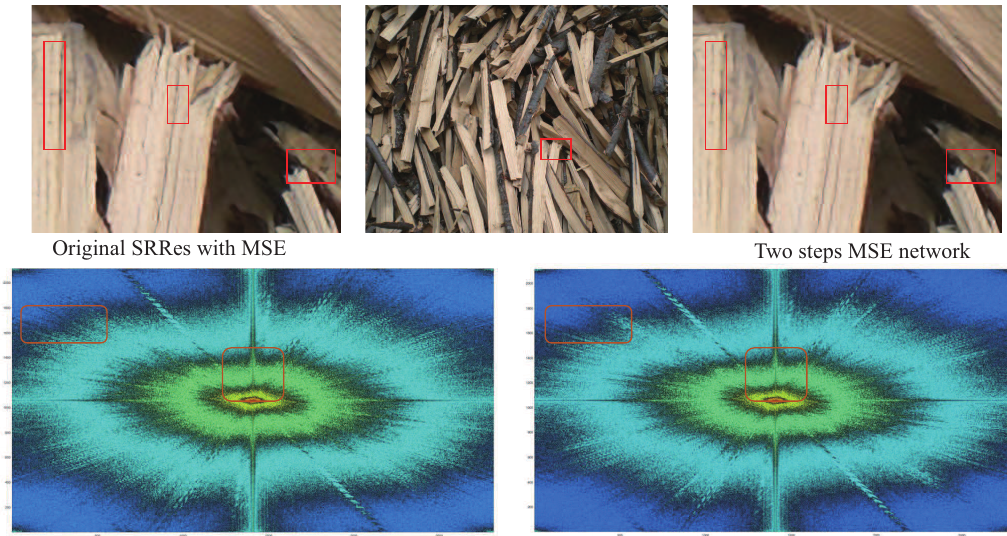
Figure 5. Details comparison between SRRes and two-step learning with MSE loss. From the left box, we can acquire that clear growth ring is generated with new structure. It is also shown in the spectral image.